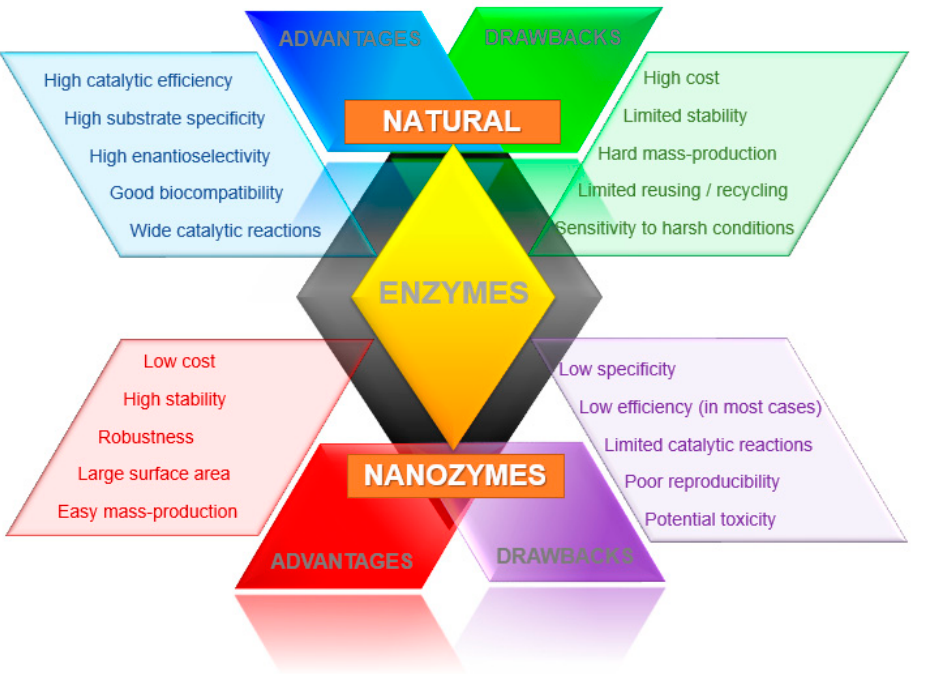
Figure 2. Comparison of some characteristics between nanozymes and natural enzymes.